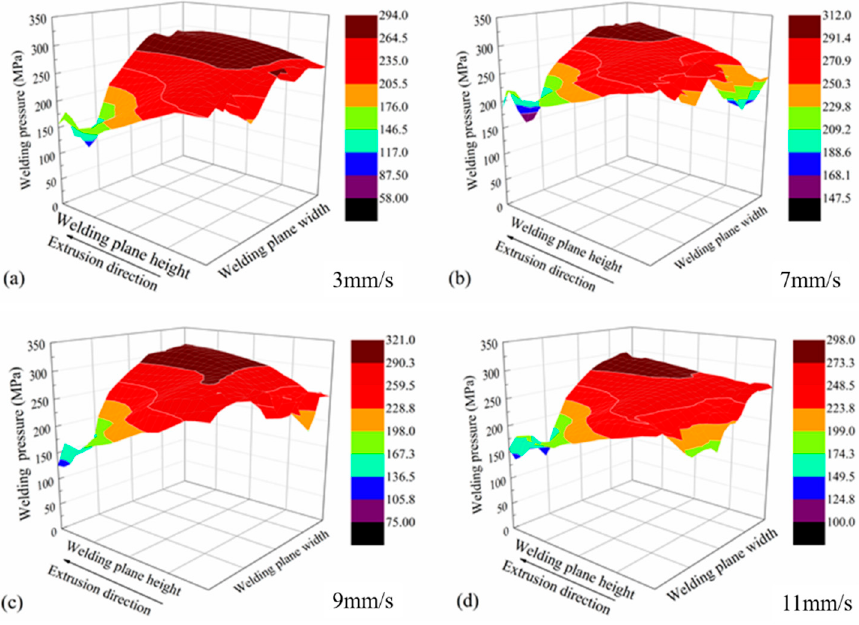
Figure 4. Welding pressure distributions on the welding planes. ( a – d ) different ram speed.